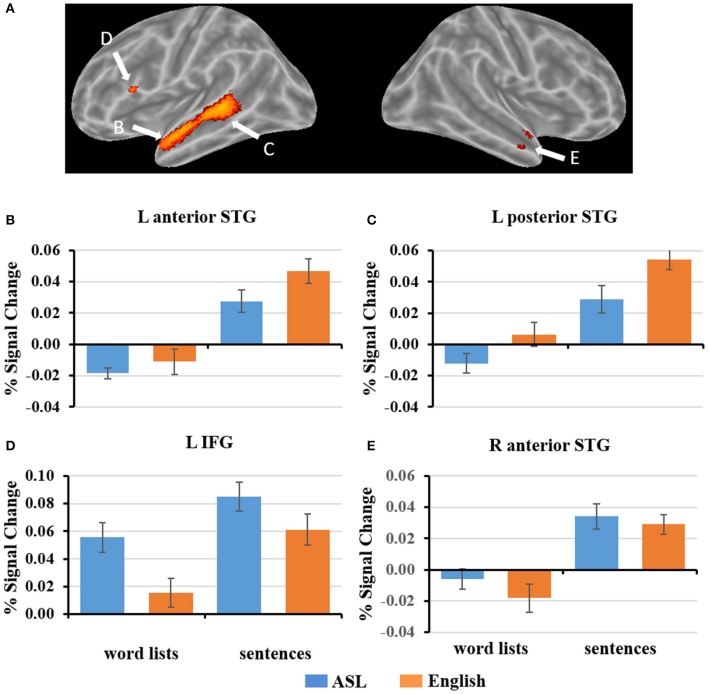
(A) ROIs defined by English sentences > English word lists (FWE corrected, p < 0.05). (B–E) Graphs of the response to each condition of select ROIs depicted in (A). Error bars represent standard error of the mean.